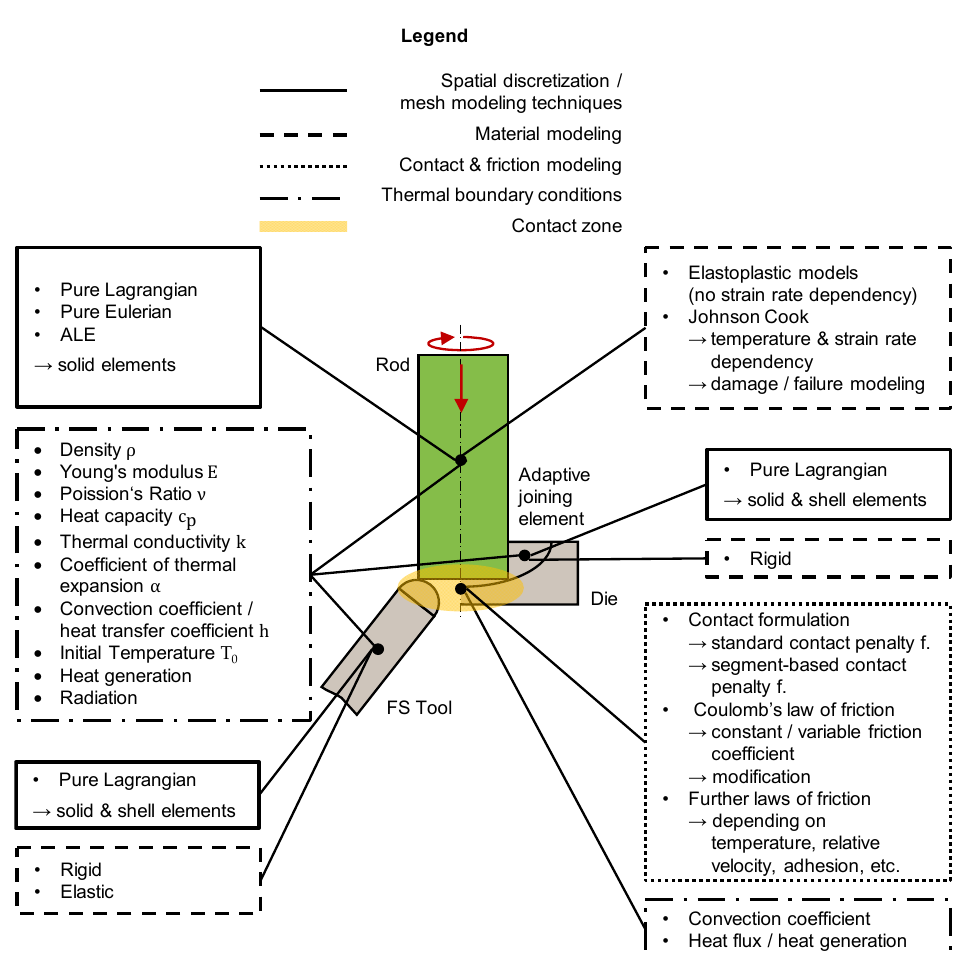
Figure 4. Overview of the boundary conditions and modeling approaches for simulating the adaptive joining process, divided into the process steps of shaping the adaptive joining element and the joining process with pre-holed workpieces.